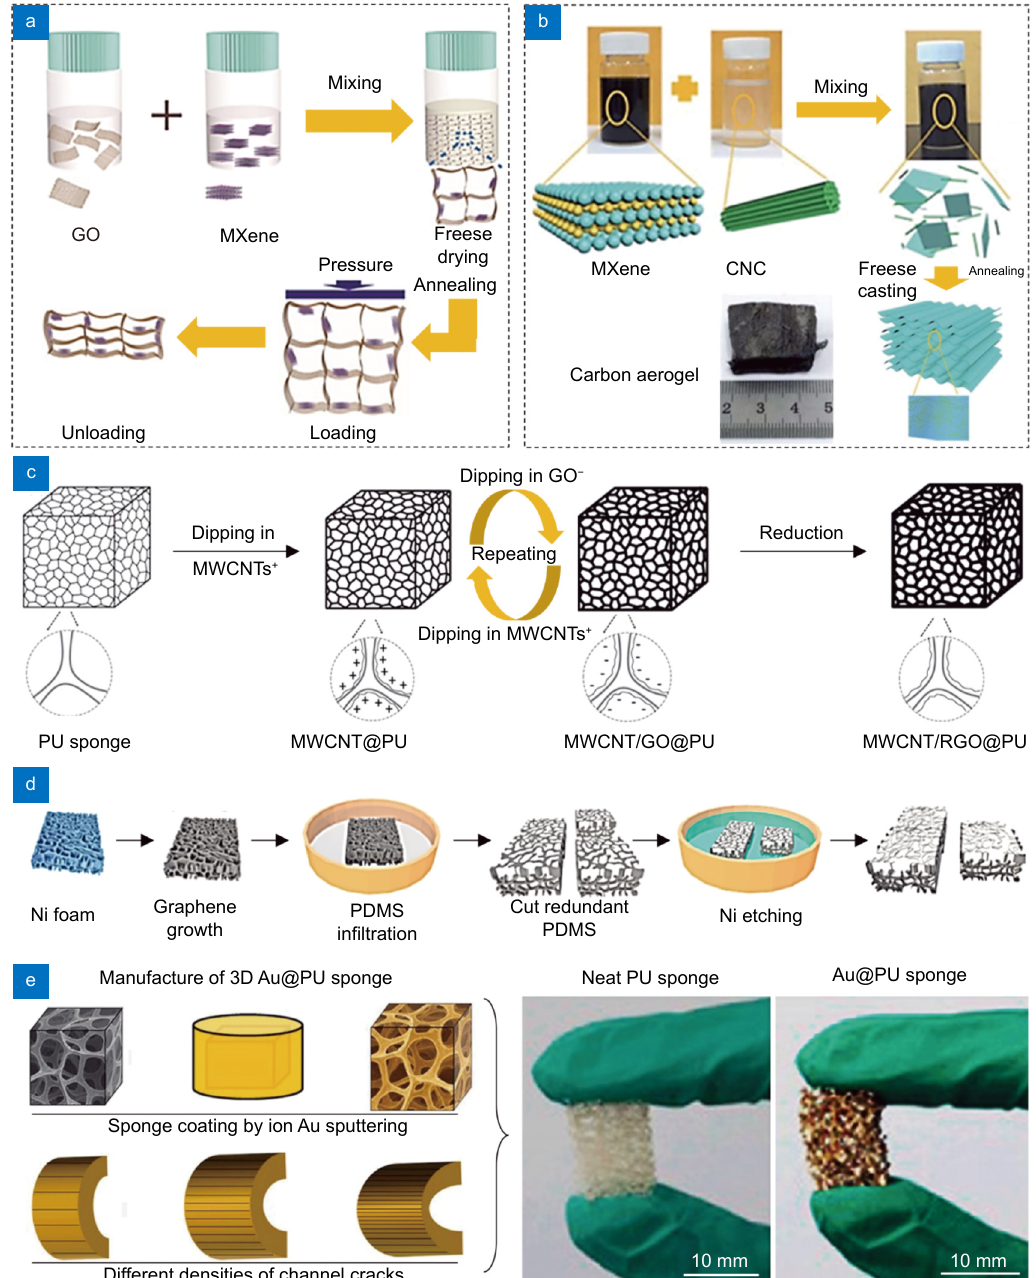
Fig. 8 | Piezoresistive design and manufacture with spongy structure. ( a ) Freeze drying for the fabrication of piezoresistive sponge 68 . ( b ) Dir- ectional freeze drying of the fabrication of piezoresistive wave-shaped sensing layers 127 . CNC, cellulose nanocrystals. ( c ) Dip coating of as-fabric- ated sponge with conducting materials 130 . PU, polyurethane; and MWCNT, multiwalled carbon nanotubes. ( d ) Sacrificial template for the fabrica- tion of piezoresistive sponge 131 . ( e ) Sponge-based hierarchical structure (e.g. cracks) for piezoresistive sensor 134 . Figure reproduced with permis- sion from: (a) ref. 68 , (d) ref. 131 , (e) ref. 134 , American Chemical Society; (b) ref. 127 , (c) ref. 130 , Royal Society of